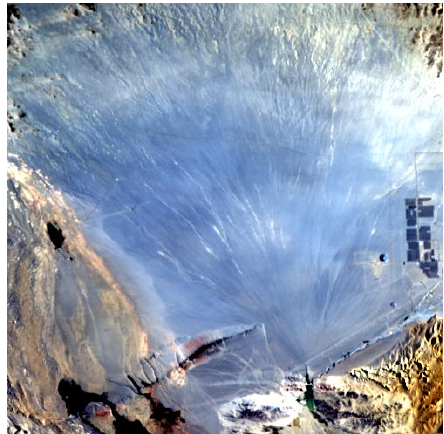
Figure 1. MWI image of Dunhuang Desert (Colour synthesis with band 7, band 5 and band 3)